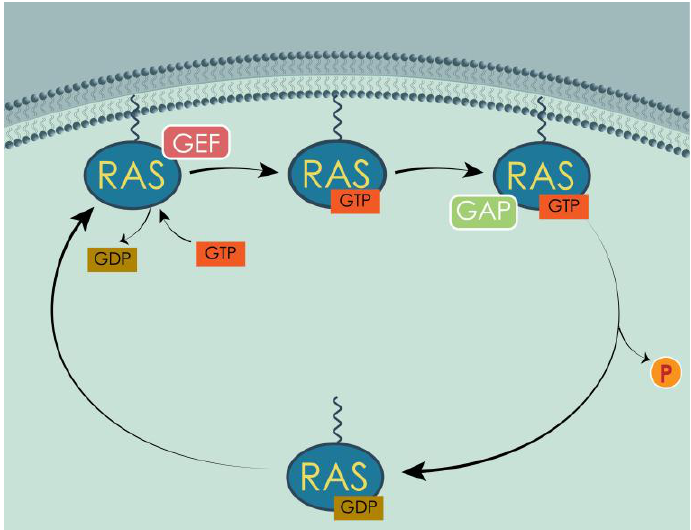
Figure 4. Inactive RAS proteins bound to GDP are localized in the cytoplasm. GEFs catalyze the liberation of GDP from the binding site, allowing GTP, more abundant in the cell, to bind instead. GTP-bound RAS are translocated to the membrane and activated. GAPs enhance the endogenous GTPase activity, hydrolyzing GTP to GDP. RAS is inactive again and goes back to the cytoplasm, where the cycle can begin again, upon proper stimulus.